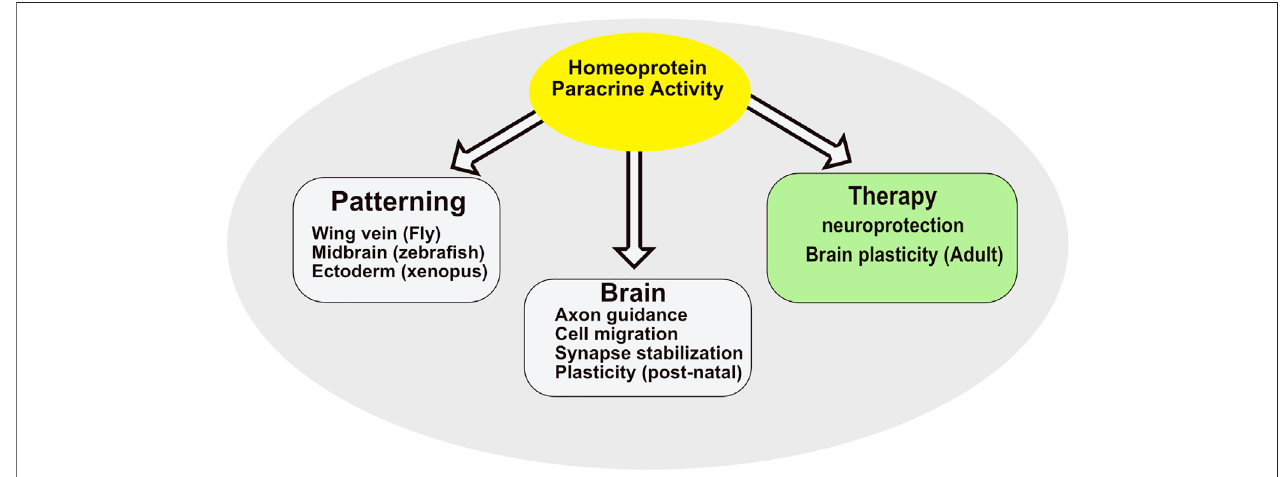
FIGURE 3 | Summary of homeoprotein paracrine